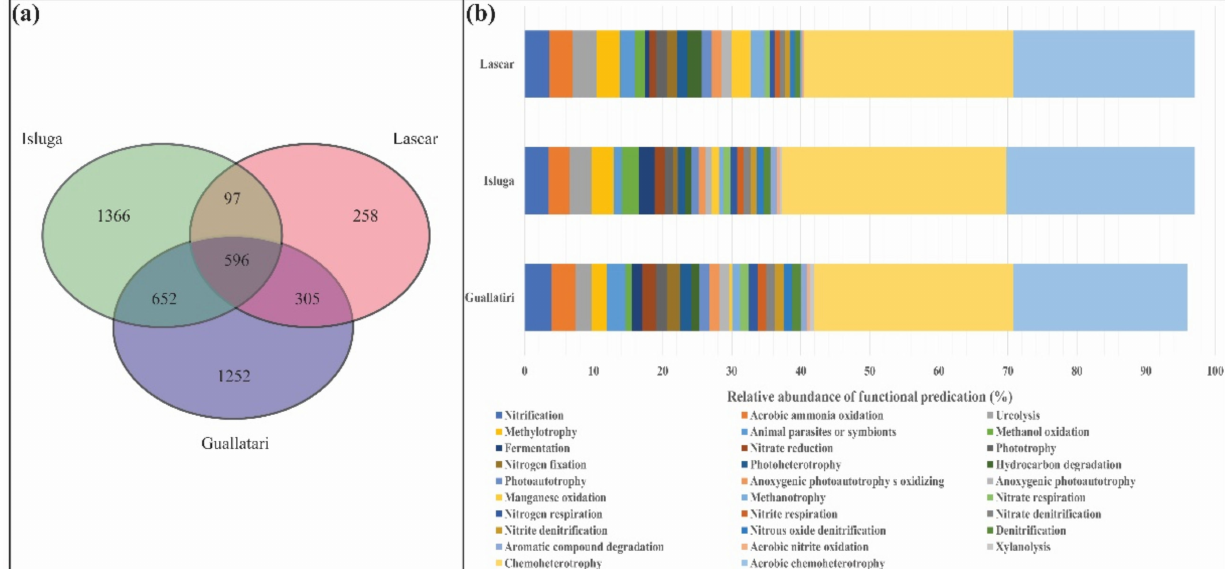
Figure 4. ( a ) Shared operational taxonomic units (OTUs) among bacterial communities in the rhizo- sphere of P. quadragularis grown at the Guallatiri, Isluga, and Lascar volcano sites. ( b ) Mean relative abundances of microbial functional groups in the rhizobacterial communities of the P. quadragularis grown at the the Guallatiri, Isluga, and Lascar volcano